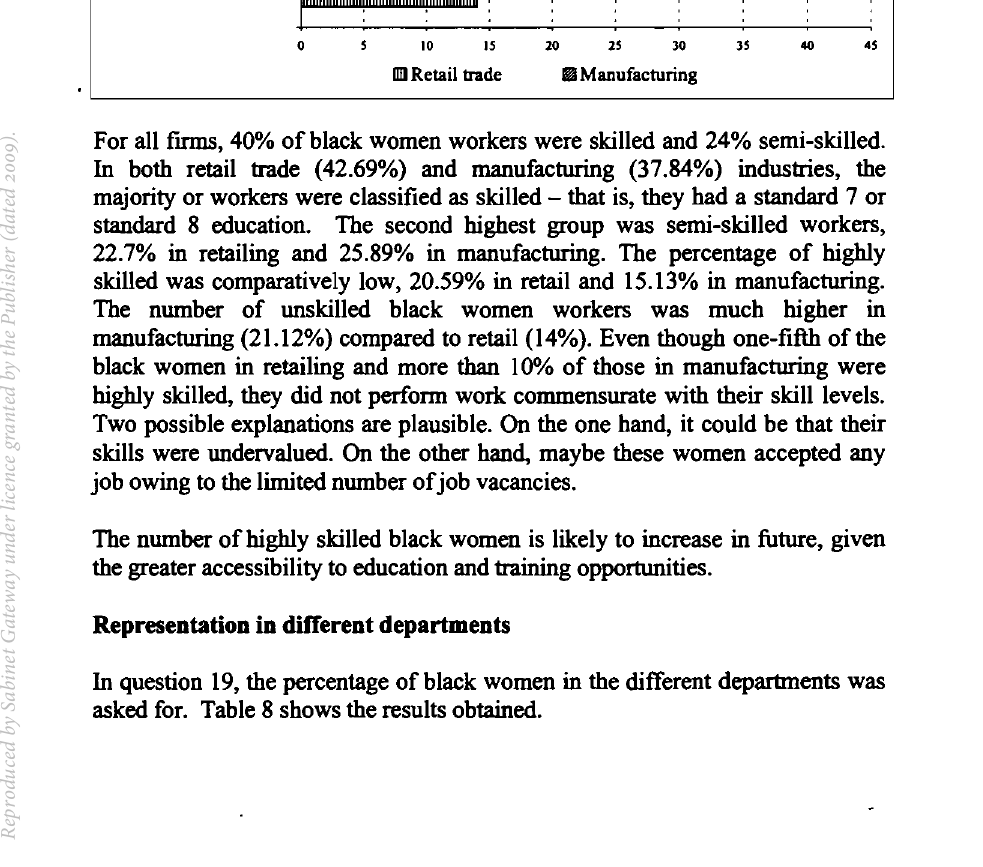
Skilled (SId 7 or 8 " rew months